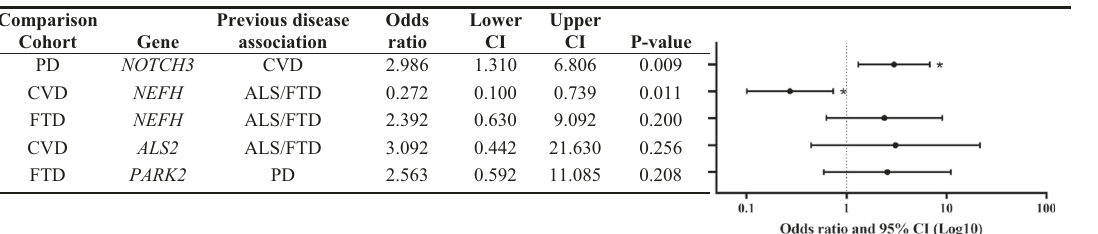
Table 4. Gene-based rare variant association analyses using Firth logistic regression comparing rare variant enrichment between the individual ONDRI cohorts, in genes identi fi ed as having differing enrichment by